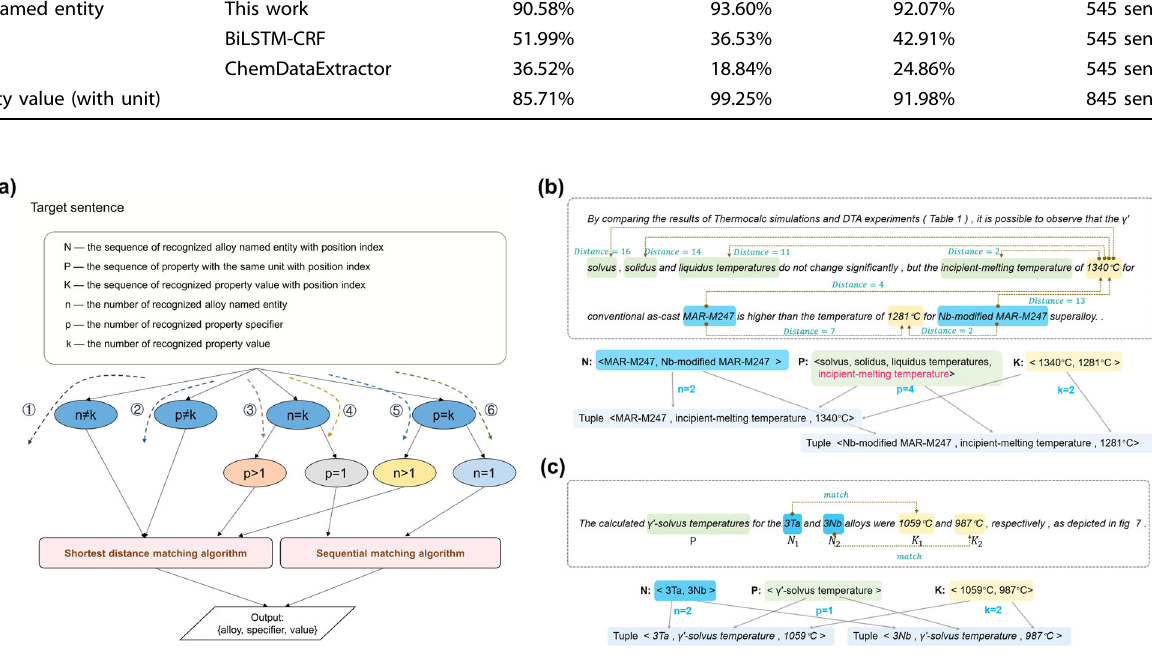
Fig. 3 The algorithm of text relation extraction. a Algorithm fl ow chart of relation extraction by shortest distance matching and sequential matching. The number of words and word sequences between entities can act as the main syntactic features in feature-based relationship extraction methods. b Schematic of shortest distance matching algorithm. c Schematic of sequential matching algorithm. The phrases in blue, green, and yellow rectangle are recognized as alloy named entity, property speci fi er, and property value by NER,